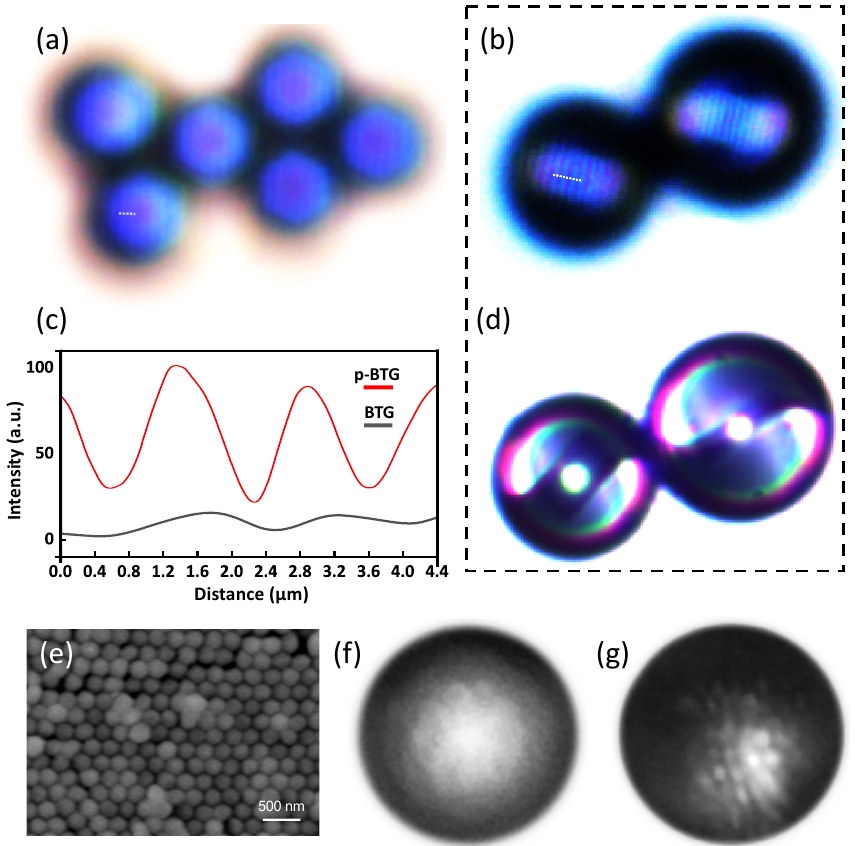
Figure 2. ( a , b ) OM images of the pattern on BD surface observed through ( a ) pristine BTG and ( b ) p-BTG with the 20 × objective; ( c ) optical intensity profiles across the white dash lines; ( d ) OM image of the corresponding p-BTG; ( e ) SEM image of the 230 nm-diameter SiO 2 particle arrays; ( f , g ) the SiO 2 particle arrays observed through ( f ) pristine BTG and ( g ) p-BTG